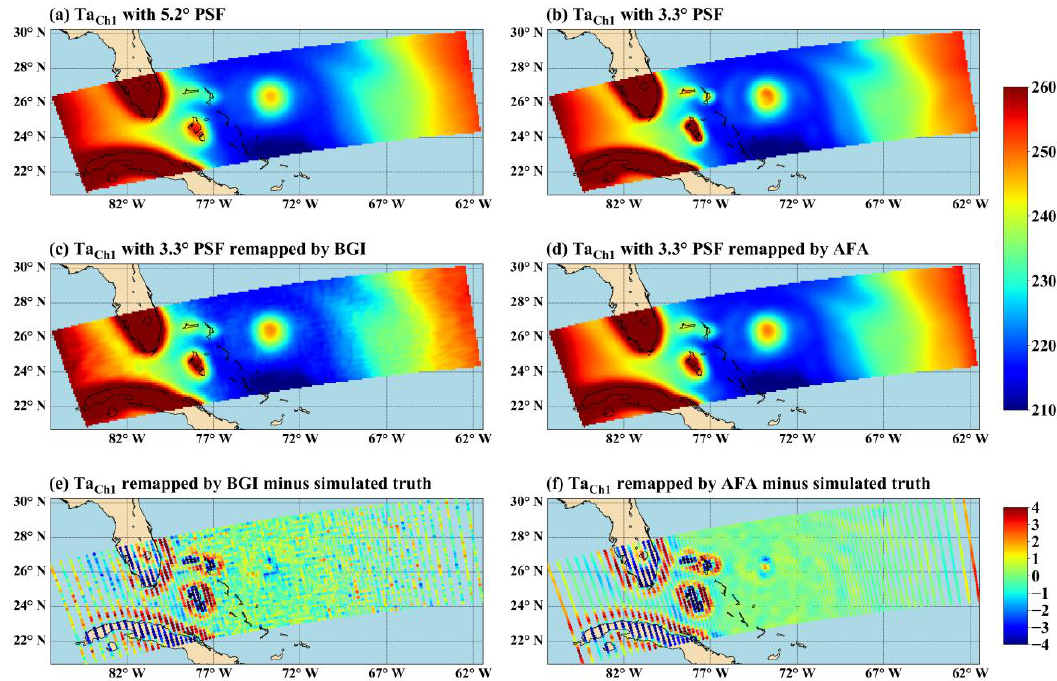
Figure 5. Simulation results of ATMS channel-1 resolution enhancement from the original 5.2° FOV to the expected 3.3° FOV. Simulated ( a ) original and ( b ) expected observations; remapped observations by ( c ) the BGI and ( d ) the AAPP Filter Algorithm (AFA); the difference between the remapping results of ( e ) the BGI and ( f ) the AFA and the simulated truth (remapping minus truth). Units are